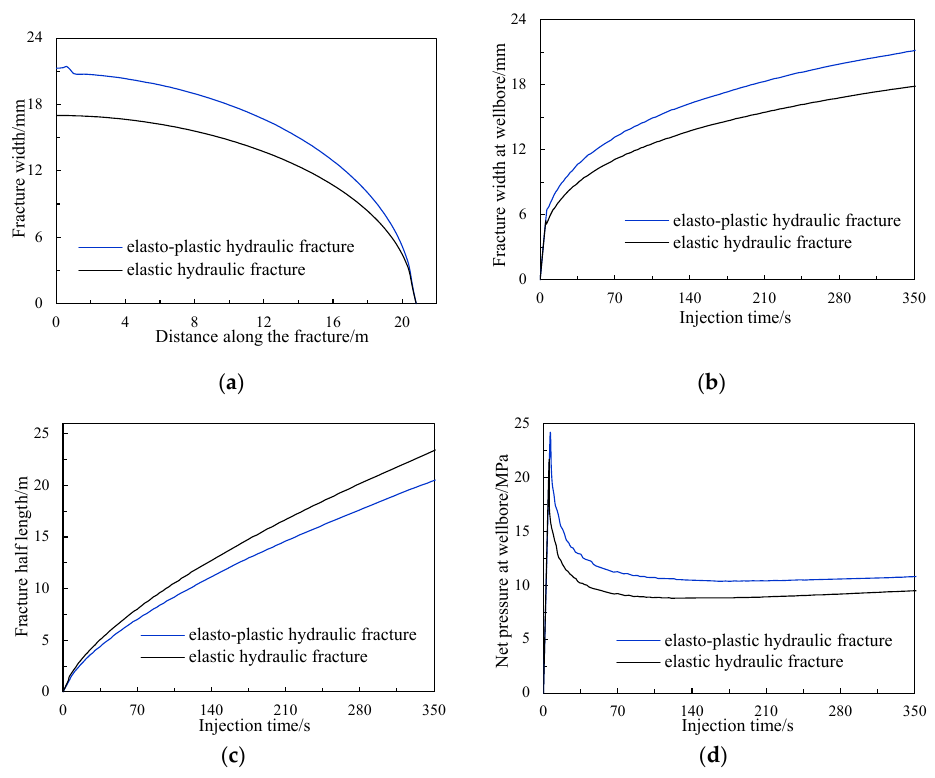
Figure 11. Comparison between elasto-plastic and elastic hydraulic fracture. ( a ) Fracture width profiles for same fracture length; ( b ) fracture width at wellbore; ( c ) fracture half-length; and ( d ) net pressure at wellbore.